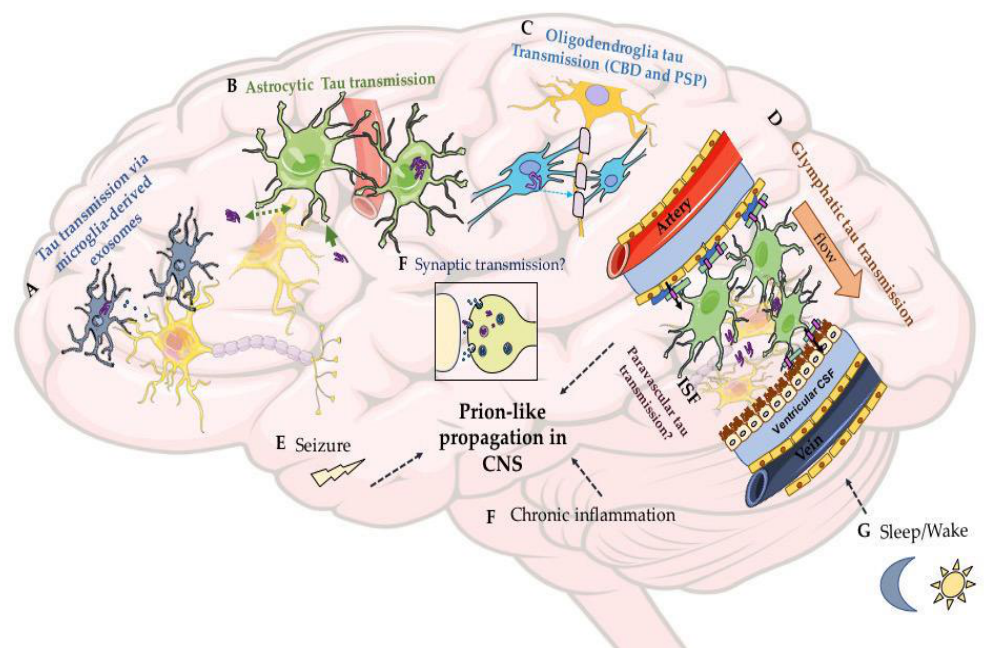
Figure 4. Various hypothesized mechanisms and vectors of the prion-like spreading of tau pathology between tissues. ( A ) Tau can be phagocytosed by microglia, transported, and then released via exosomes, which contribute to the spreading of tau pathology. Tau can be internalized by non-neuronal cells, such as ( B ) astrocytes or ( C ) oligodendrocytes, which contribute to glial tau transmission in tauopathies other than AD such as CBD and PSP. ( D ) One of the recently studied mechanisms that may account for the spread of tau pathology is the glymphatic system’s involvement (the structural organization of panel D is inspired by schematics in [284–286]). In this system, free tau can be cleared from the ISF using the CSF influx into the extracellular spaces within the brain parenchyma. The CSF influx flows directionally through the aquaporin four (AQP4) channel (colored in pink) [205] that is highly expressed in the end-feet of astrocytes lining the arterial and venous perivascular spaces (described in [204]). Various factors that may affect tau spreading and aggregation also need to be considered, including ( E ) the role of seizures, ( F ) synaptic connectivity and transmission, and ( G ) sleep / wake cycles and disruptions. Investigating these mechanisms, vectors, and factors impacting tauopathy progression is a priority area and urgently requires improved animal models of